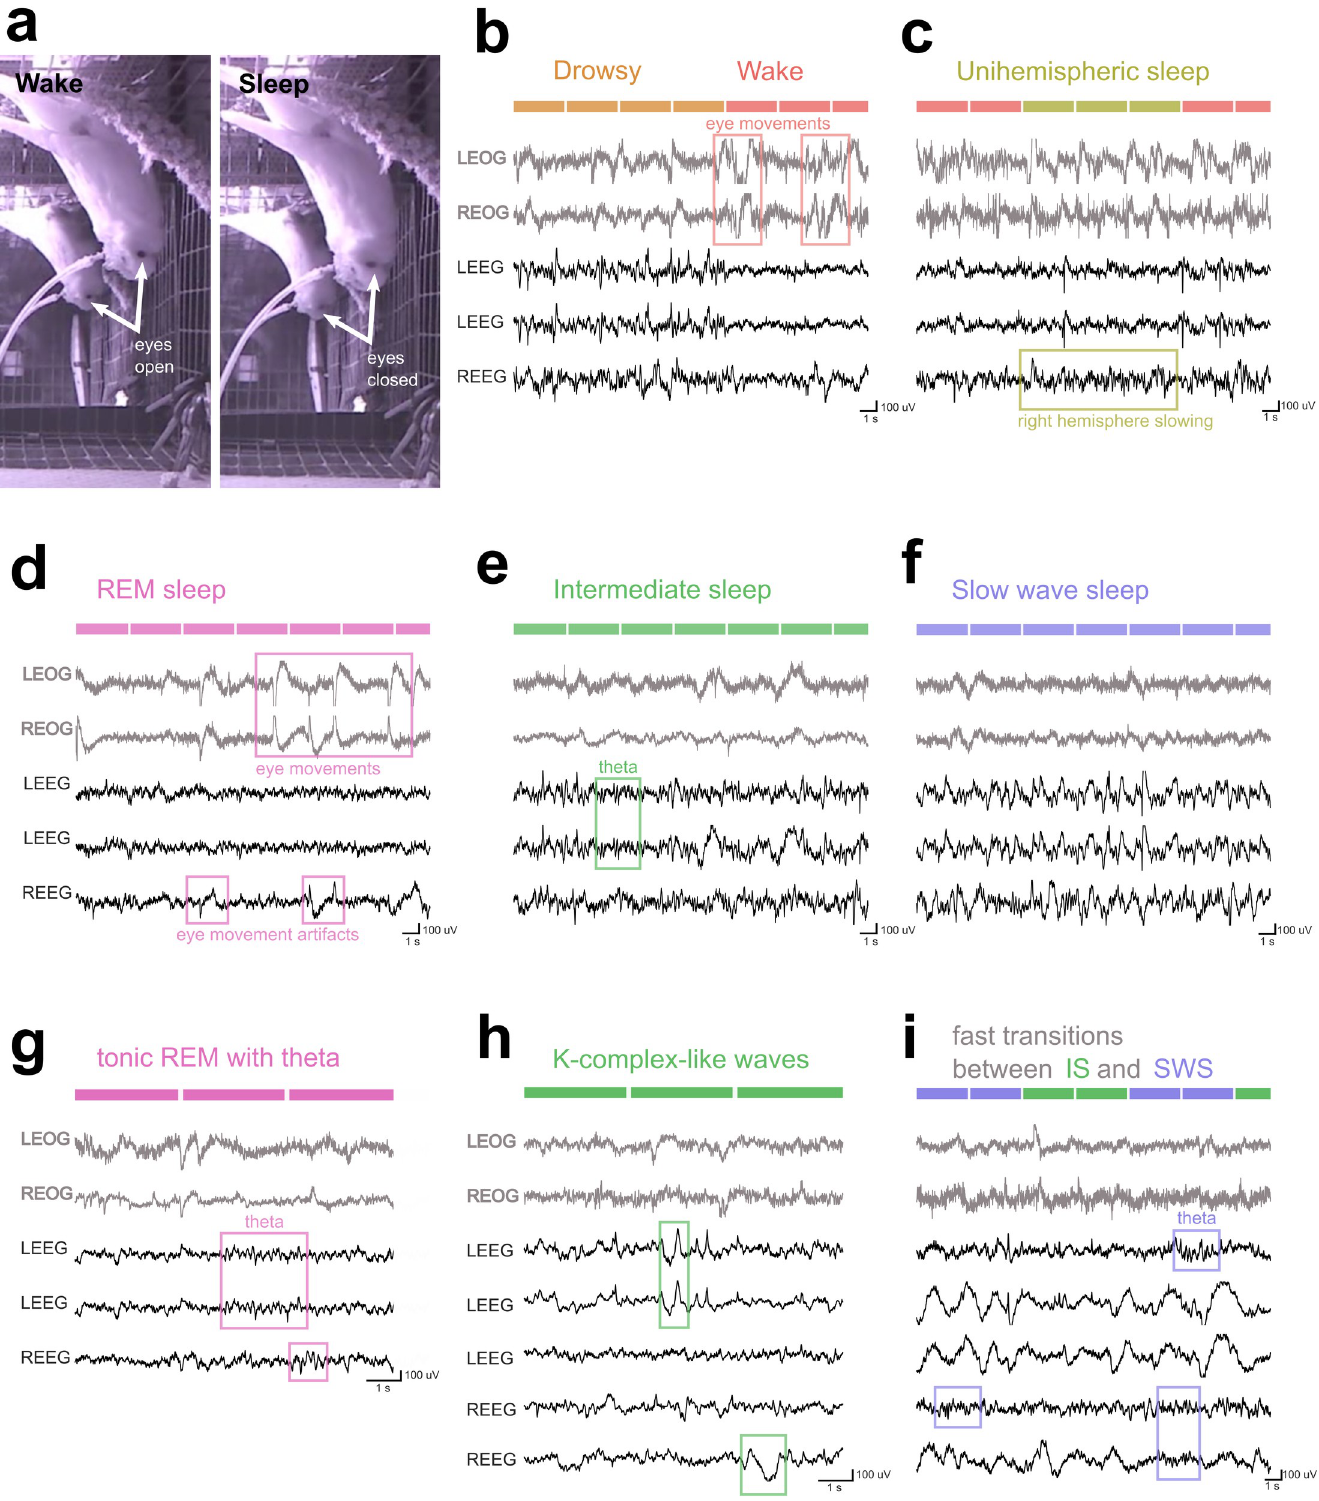
Fig 1. Examples of video and PSG data. (a) Infrared image of Bird 4 falling asleep at night while hanging from the ceiling of the enclosure. The bird is facing the cage wall on the right of the picture. A mirror on the back wall reveals the eye contralateral to the camera. During the brief awakening (left), both eyes were open; contrast with closed eyes (right) during sleep (2 images separated by approximately 6 min). (b–h) Example PSG recordings. The upper 2 EOG traces are gray; the lower EEG